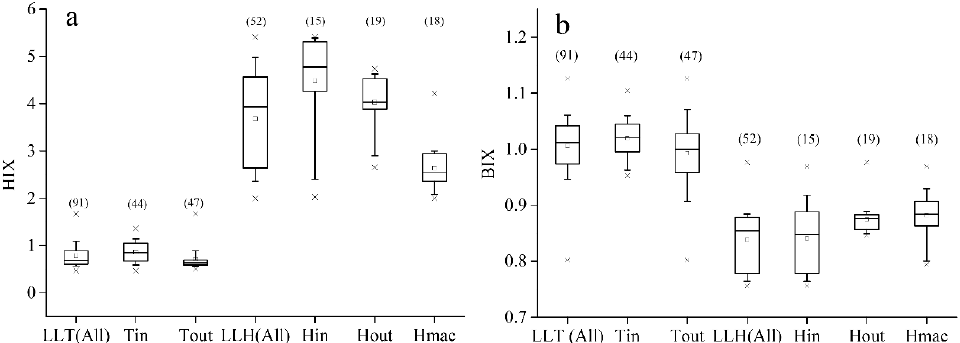
Figure 5. Box plot comparison of the humification index (HIX) and the biological index (BIX) in littoral zones of Lakes Taihu and Hongze: HIX ( a ); BIX ( b ). Boxes represent the 25th and 75th percentile; center horizontal line represents the median; square represents the average; whisker ends represent the 10th and 90th percentile; furcation ends represent smallest and largest values; and values in brackets indicate the number of samples.